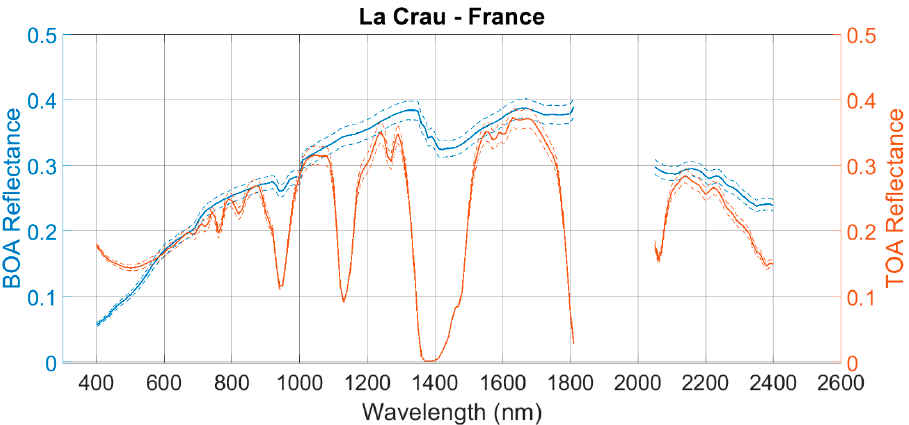
Figure 7. In the y -axis left and right side of the graph is presented, respectively, the BOA and TOA reflectance of La Crau (LCFR) measured in-situ on September 9, 2019.